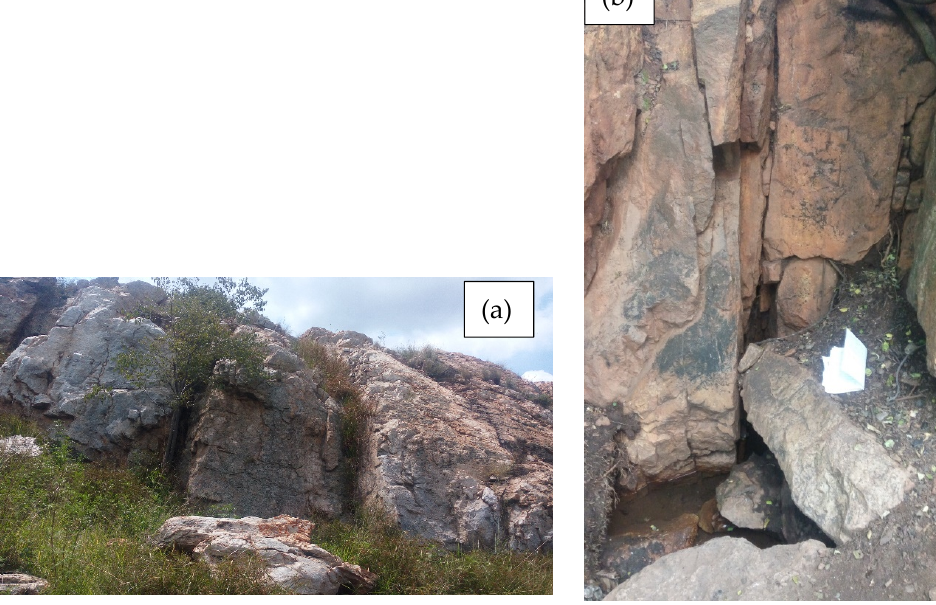
Figure 2. The quartzite on the southern boundary of the UCRB ( a ) and the fractured quartzite rocks that host the Albert Farm spring ( b ).